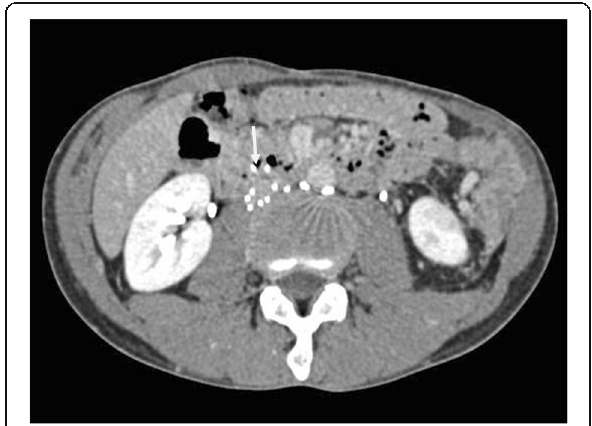
Fig. 2 Computed tomography (CT) revealed that IVC filter strut penetrated the third portion of the duodenum